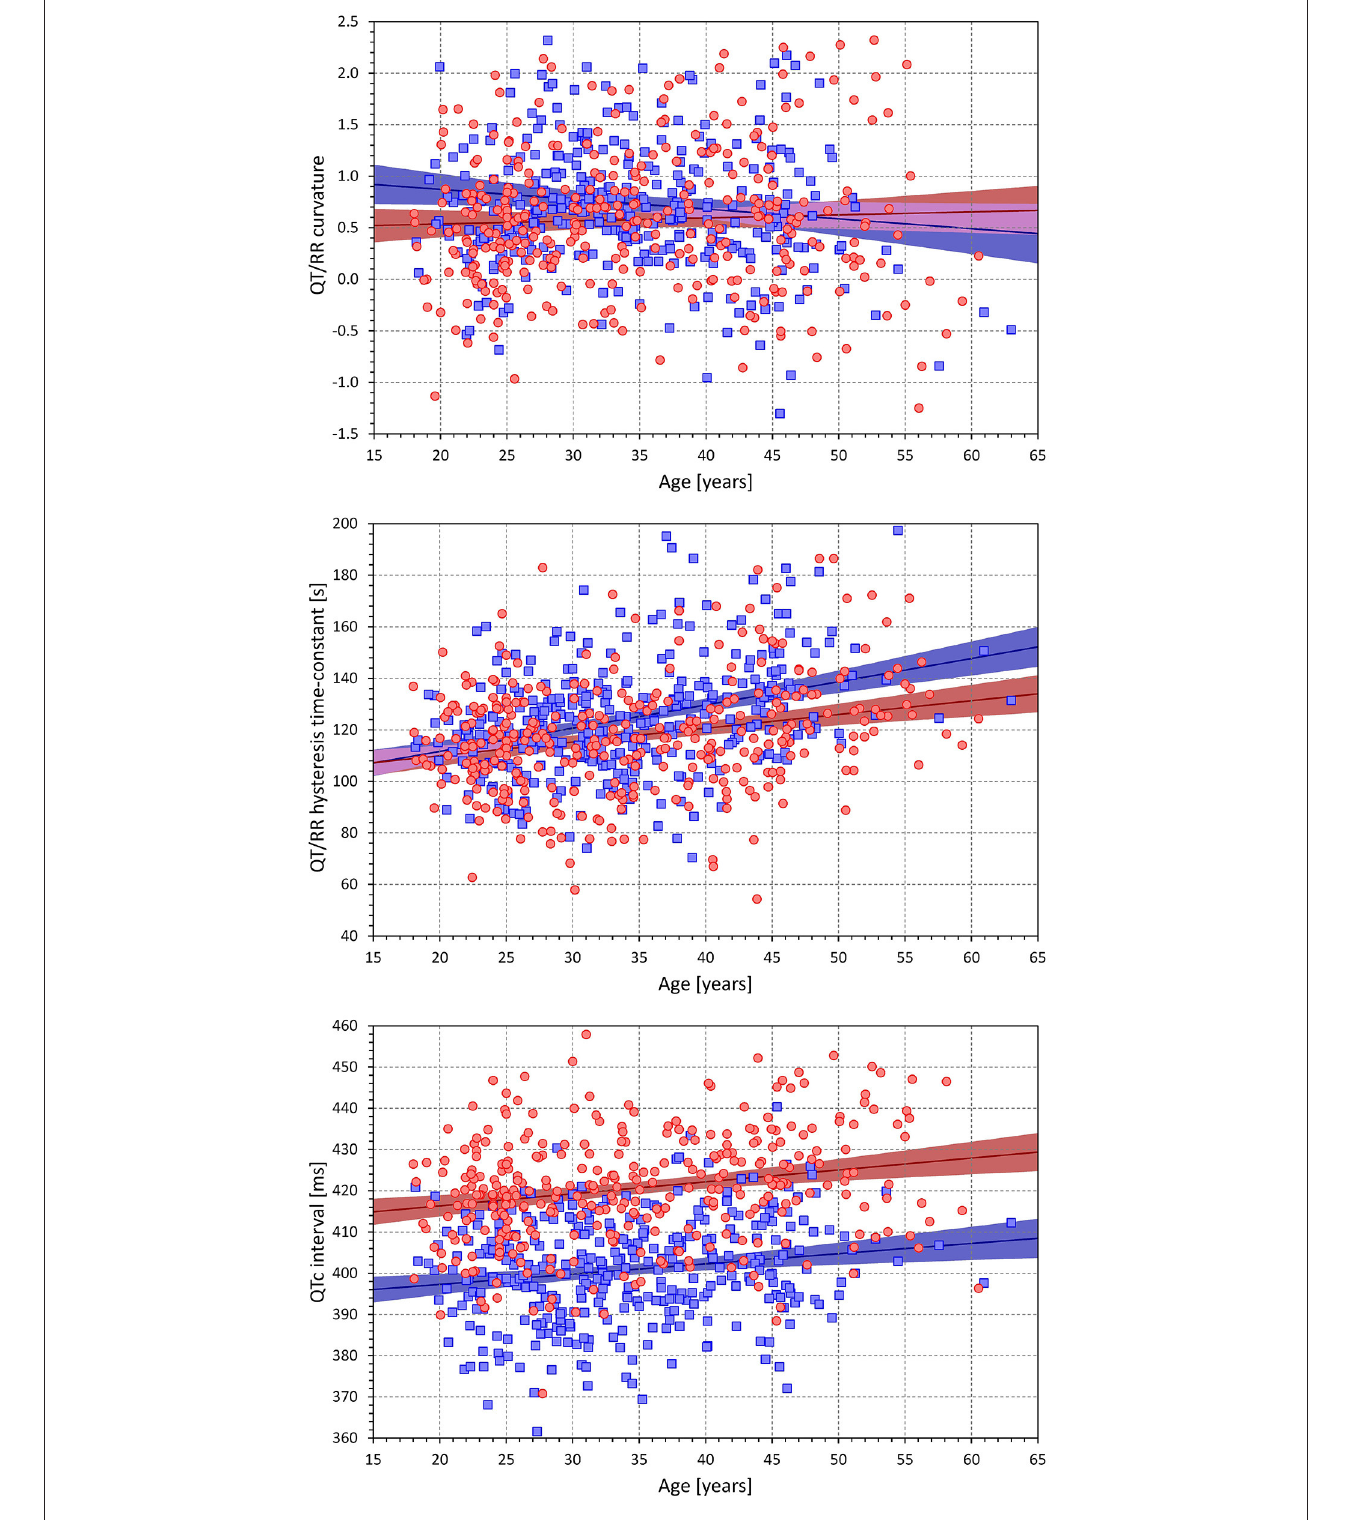
FIGURE 10 | Scatter diagrams showing age influence on the subject-specific curvatures of the QT/RR H curvature model combined with time-based QT/RR hysteresis (top panel), on the subject-specific hysteresis time-constants of the QT/RR H curvature model (middle panel), and on the mean of individually corrected QTC intervals